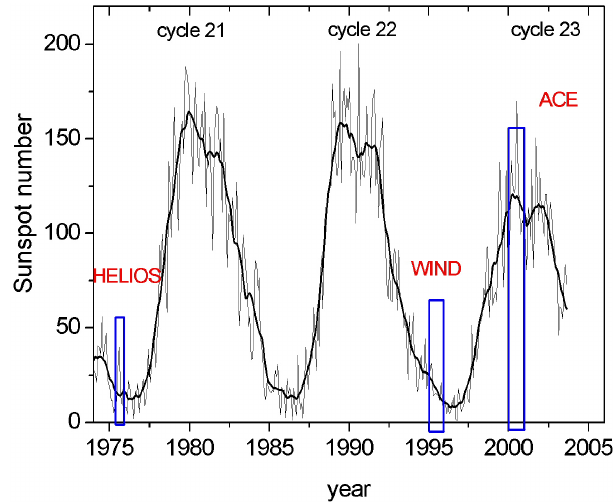
Fig. 1. Daily sunspot number as a function of time and its monthly average (smoothed curve). The boxes show the selected time inter- vals.